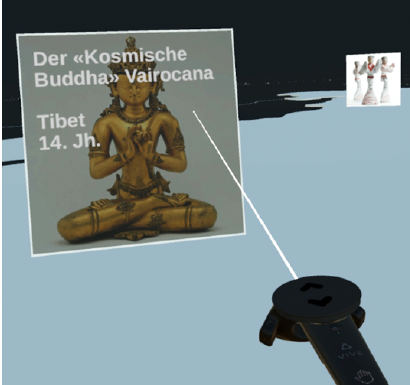
Figure 3. Radial filter menu to refine selection and perspective controller to shift the user’s perspective back and forth between bird’s eye view and ground level view.